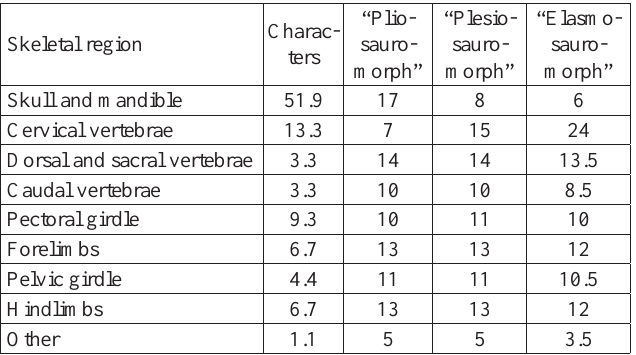
Table 1. Percentages assigned to different skeletal regions for the three plesiosaur morphotypes used here, as well as the percentage of phylo- genetic characters for each region within the character list of Benson and Druckenmiller